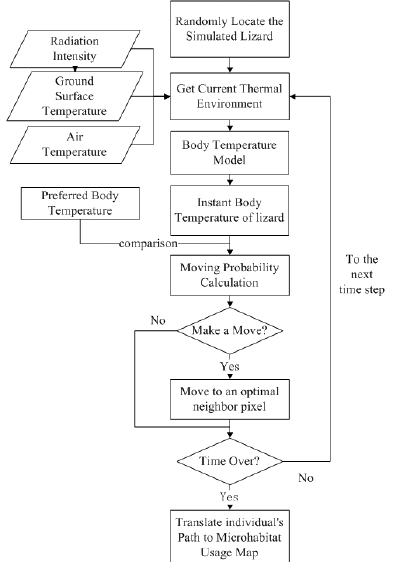
Figure 1. The flowchart of the CA